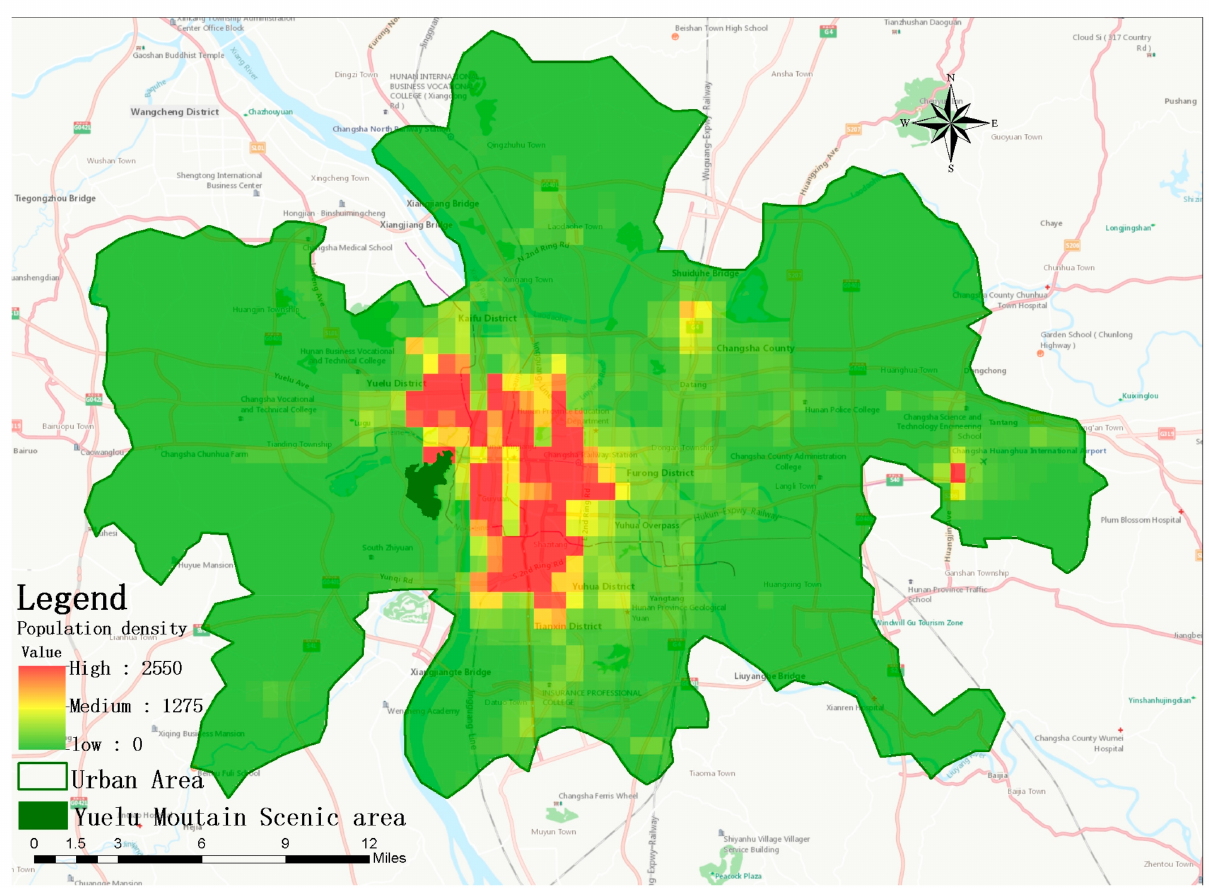
Figure 3. The population density of the urban area.